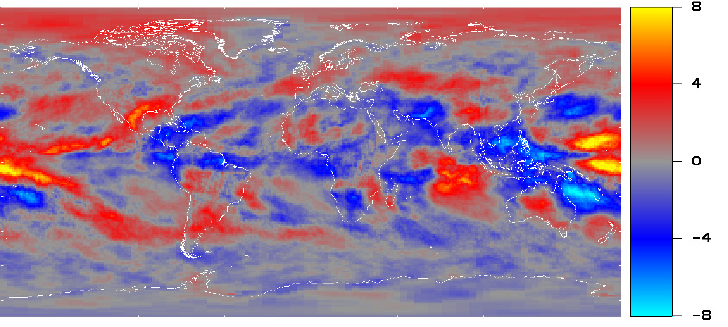
Figure 8. CERES EBAF Outgoing Longwave Radiation long-term change from 2000–2004 to